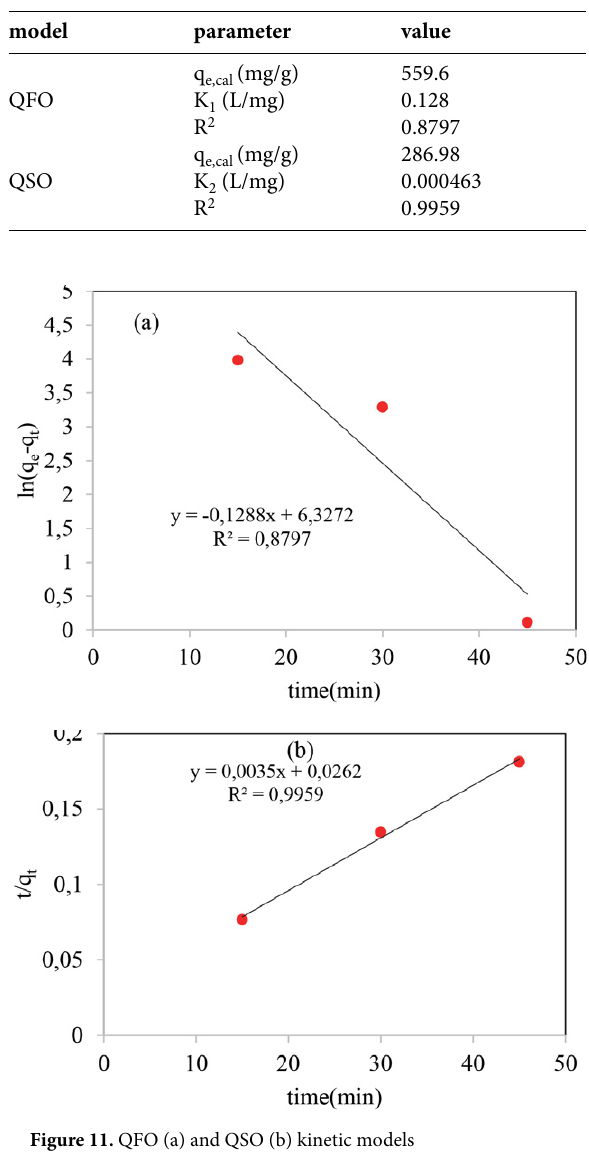
Figure 11. QFO (a) and QSO (b) kinetic